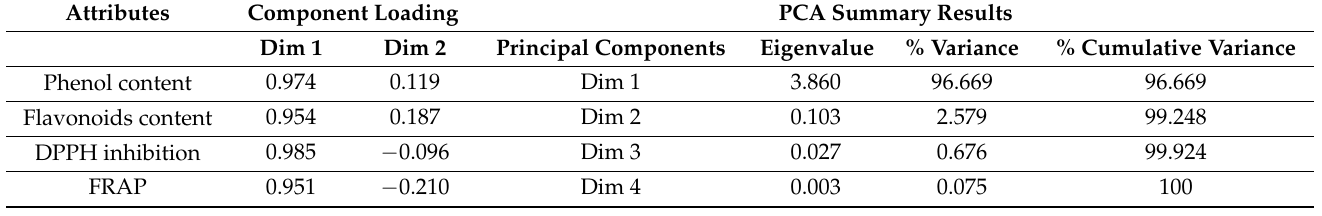
Table 4. PCA results based on functional and antioxidant activity related parameters of different formulations of Spirulina biomass enriched pasta.